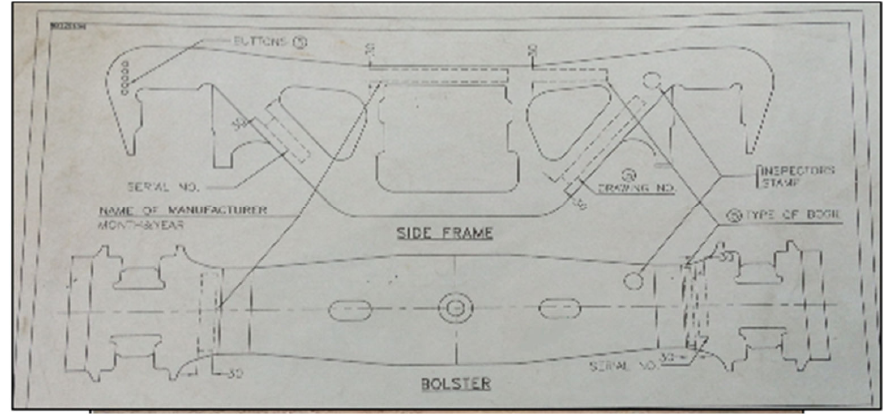
Fig. 3. 2D drawing of side frame and Bolster